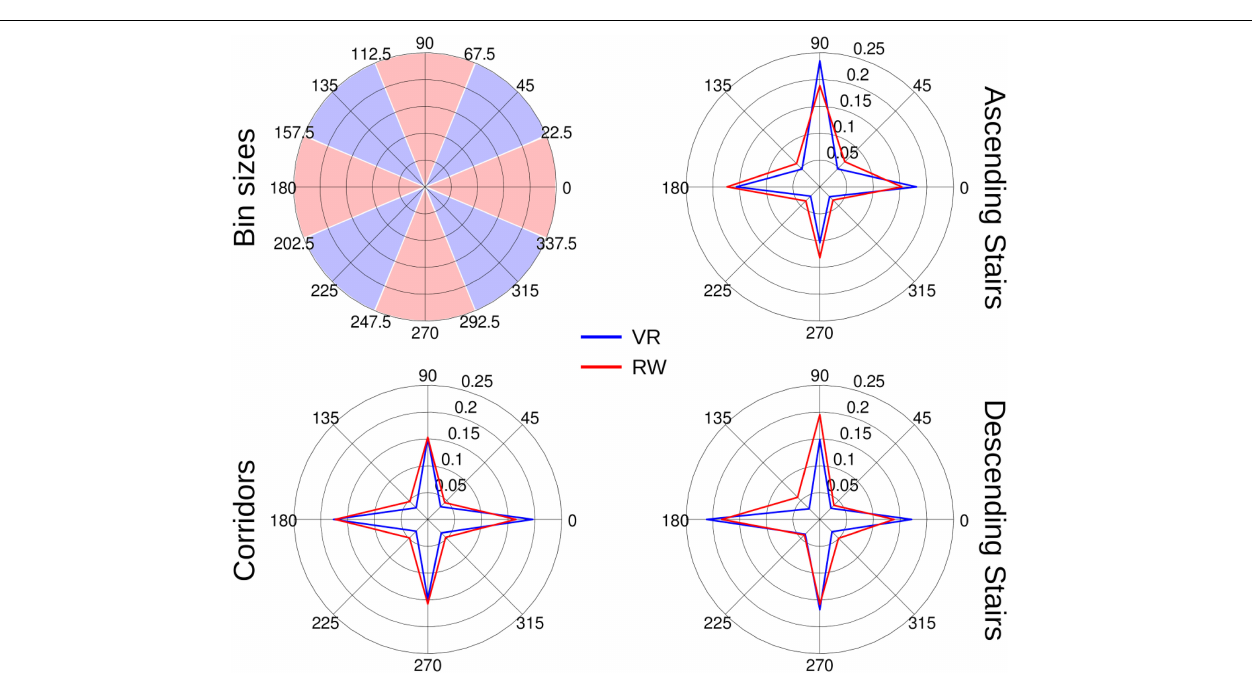
real-world bodies in their chosen walking direction.